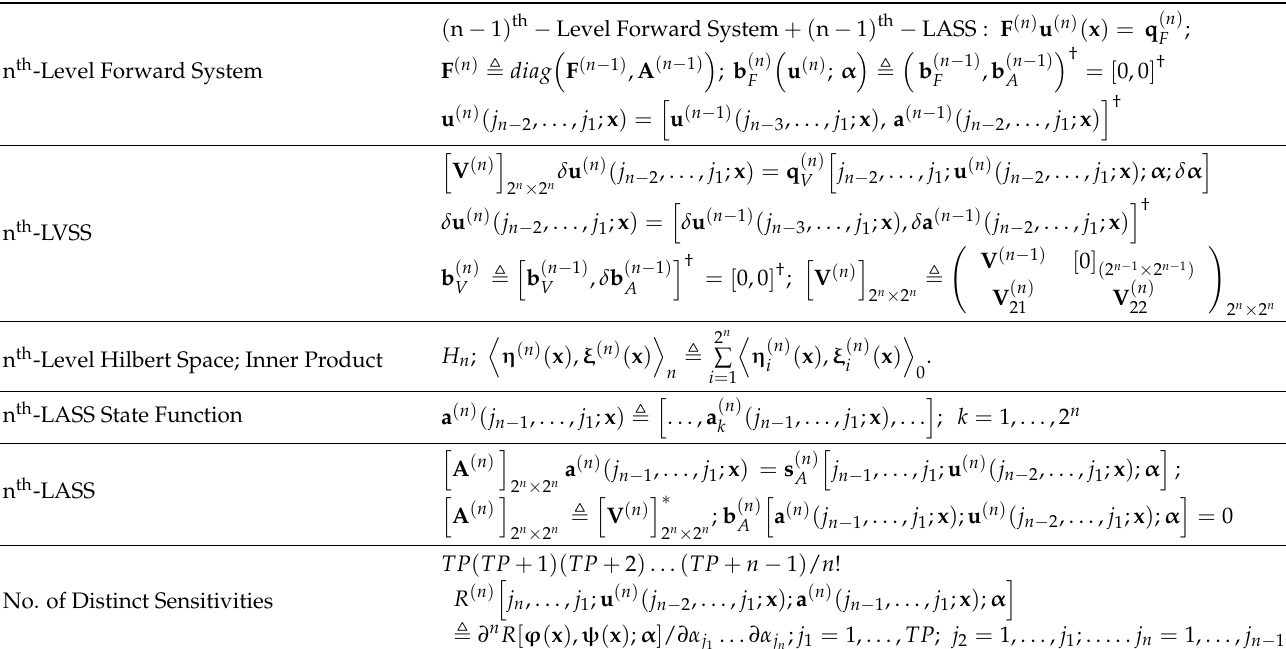
Table 5. n th -Order